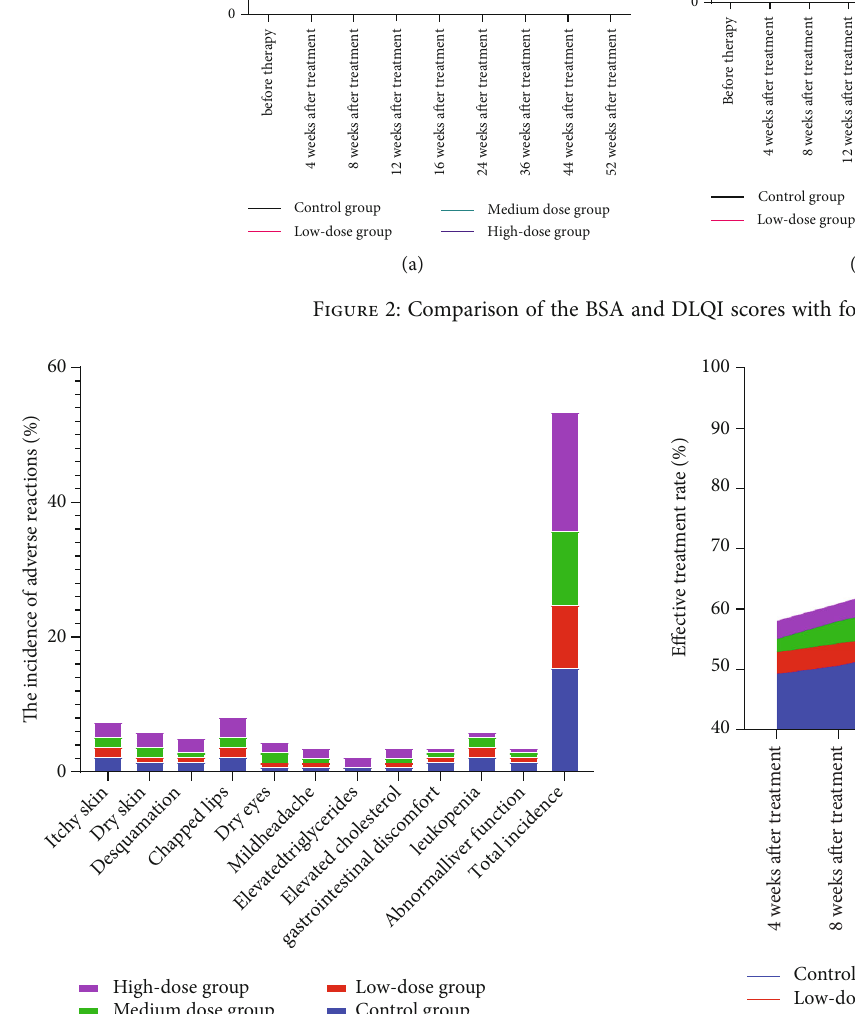
Figure 4: Comparison of the treatment e ffi ciency with four groups.